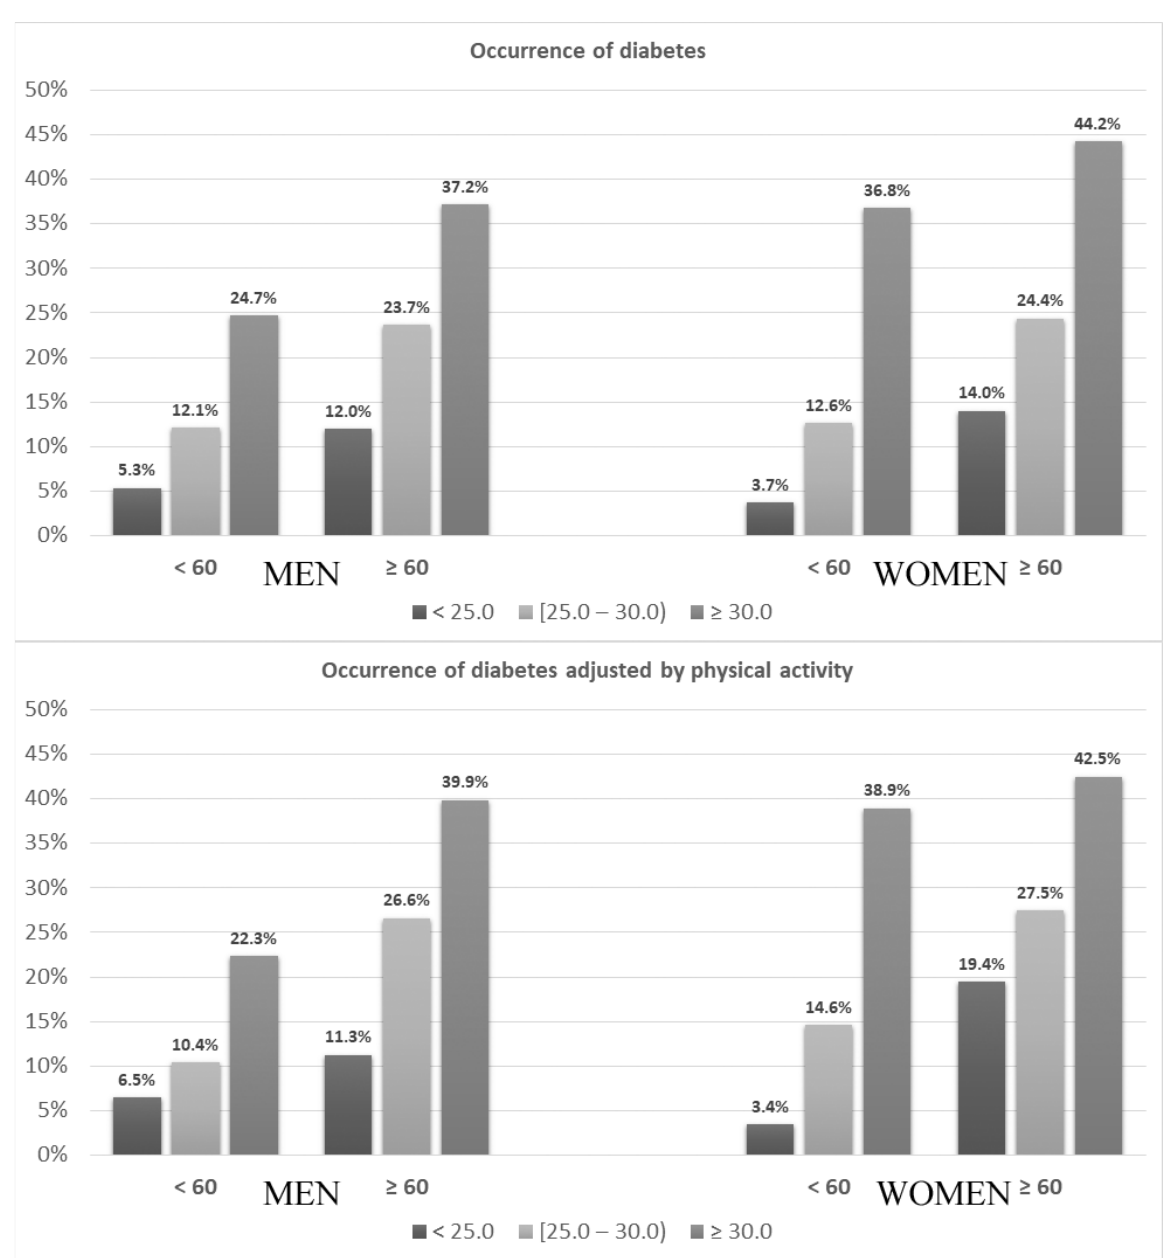
Figure 2. Occurrence of diabetes in younger and older women and men according to BMI categories without ( upper panel) and after adjustment to physical activity ( lower panel).